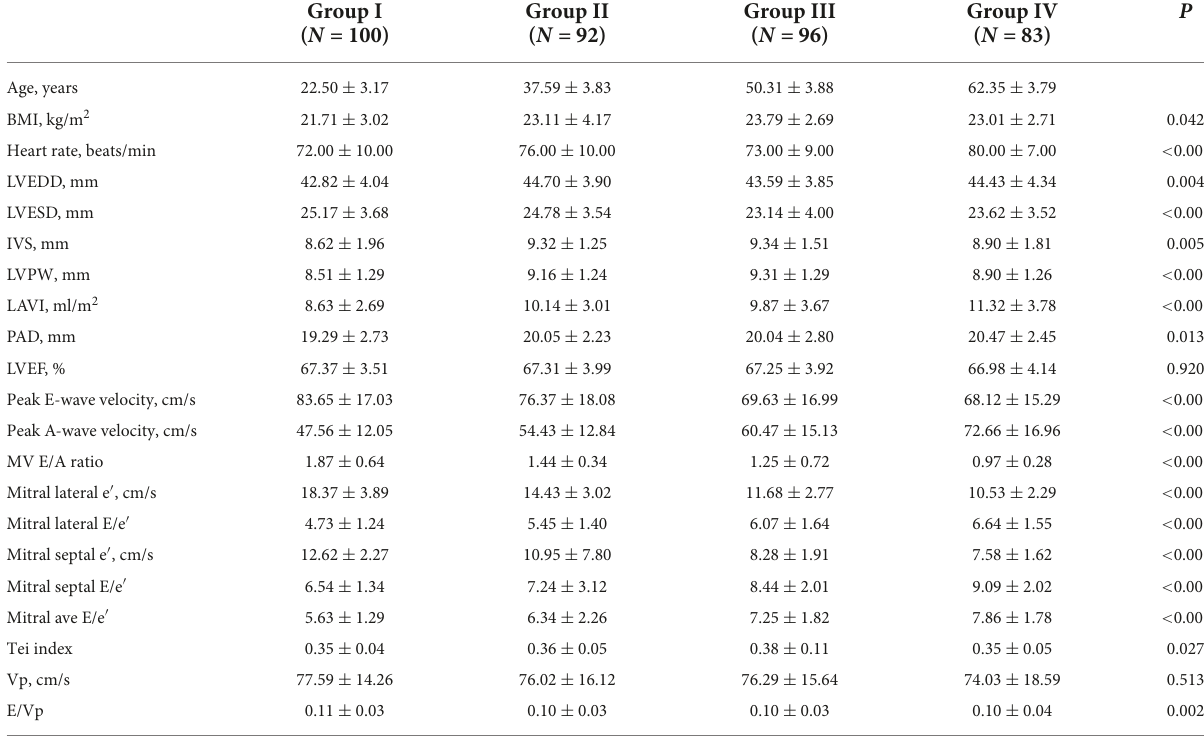
TABLE 1 Clinical and echocardiographic measurements of the study